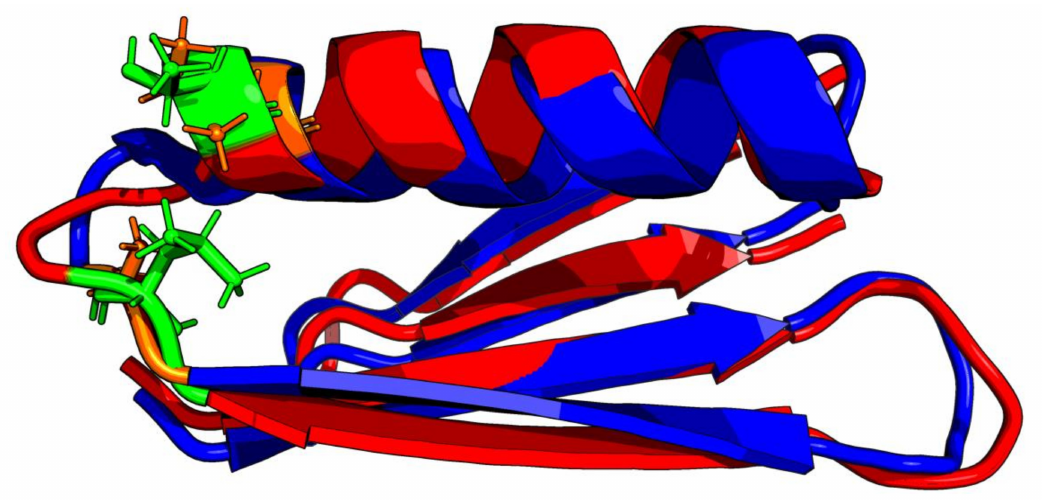
Figure 8. 3D presentation of structural superposition of Gb98 (red) and Gb98-T25I, L20A (blue). RMSD = 1.9Å. Mutated residues are additionally shown as sticks: Green—20L and 25T in Gb98, orange—20A and 25I in Gb98-T25I, L20A.